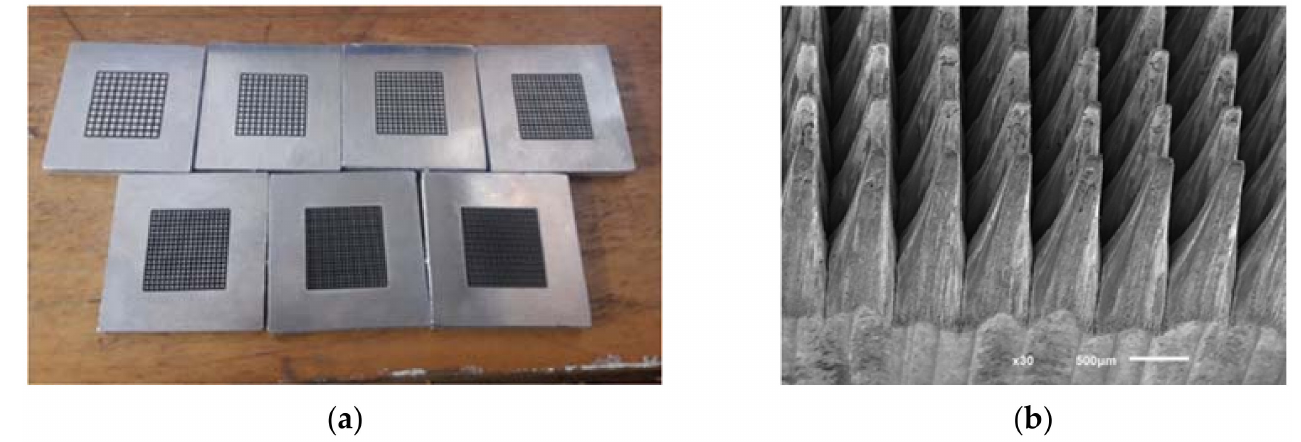
Figure 15. Textured surfaces made with diode-pumped solid-state laser (DPSSL), Neodymium Doped Yttrium Orthvanadate (Nd:YVO4) ( a ) Photos of the surfaces, ( b ) Detail of the topography obtained by